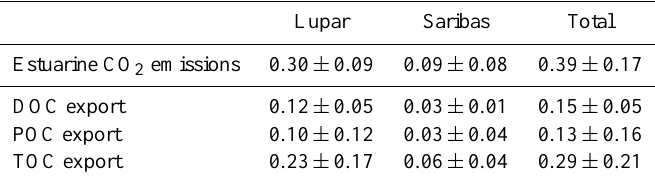
Table 4. Total carbon fluxes estimated for the Lupar and Saribas aquatic systems. All numbers are in TgCyr − 1 .